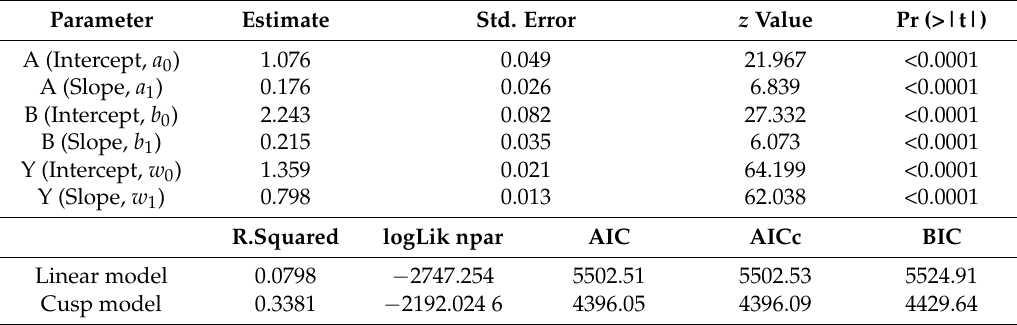
Table 4. Results from SDECusp modeling